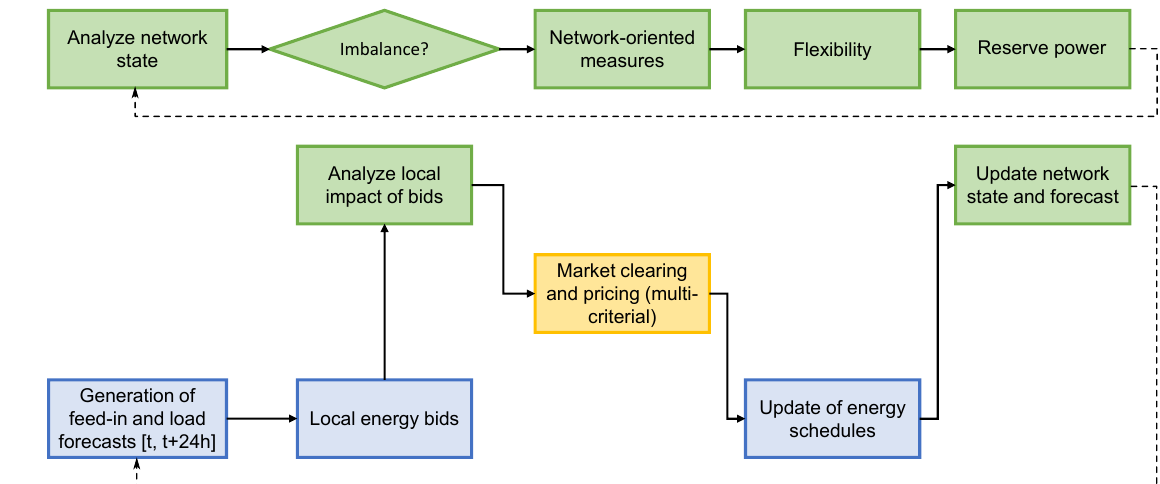
Figure 5. Operational concept for the intraday